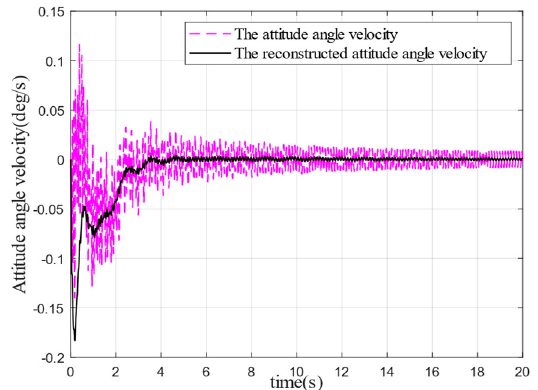
Figure 4. Attitude angular rate reconstruction without external interference.